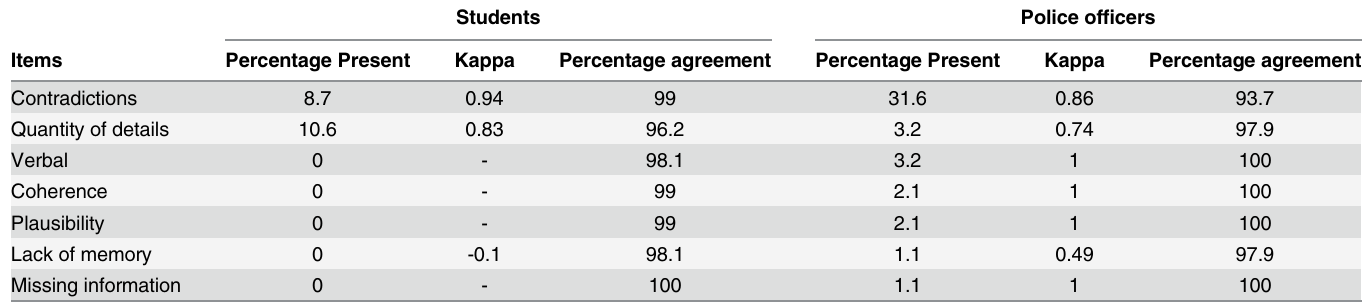
Table 2. Percentage of students (n = 104) and police officers (n = 95) mentioning verbal cues.